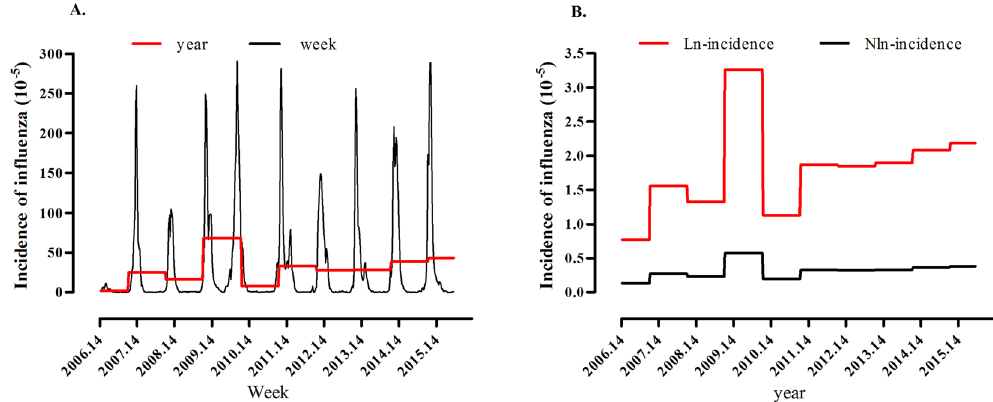
Figure 1. ( A ) The sequence chart of the influenza incidence in Nagasaki prefecture from the 14 th week of 2006 to the 36 th week of 2015. (Black lines represent the weekly incidence of influenza; Red lines represent the yearly incidence of influenza). ( B ) The sequence chart of the influenza Nln-incidence and influenza ln-incidence in Nagasaki prefecture from the 14 th week of 2006 to the 36 th week of 2015. (Black lines represent the year Nln- incidence of influenza; Red lines represent the year